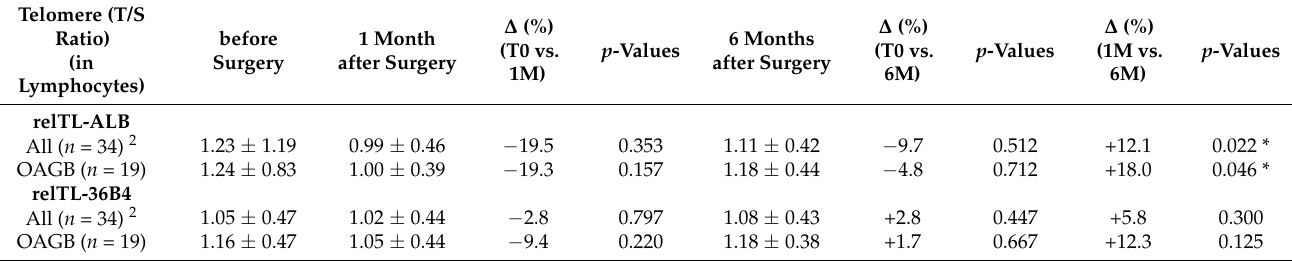
Table 3. Telomere lengths before and after bariatric surgery 1